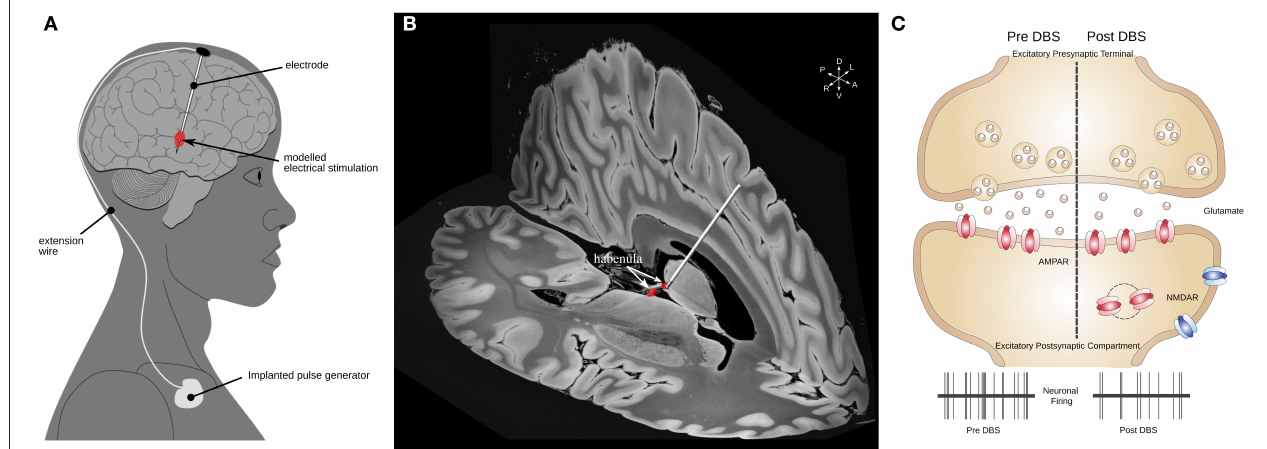
FIGURE 2 | Habenular DBS and its mechanisms of action. (A) Schematic illustrating the components of a DBS system. (B) 3-D example image of a DBS electrode targeting the left Hb (red) illustrated in MNI152 space (16) using slices from a 100 micron resolution, FLASH 7 Tesla brain (48) electrode placement performed using Lead-DBS (49). (C) Mechanisms of action of DBS in LHb. A schematic of excitatory synapse is presented. Human-inspired DBS protocols in rodents lead to a reduction in glutamate release, which subsequently reduces the neuronal activity of LHb neurons ( 41, 50). DBS, deep brain stimulation; Hb, habenula; LHb, lateral habenula; MNI, Montreal Neurological Institute.